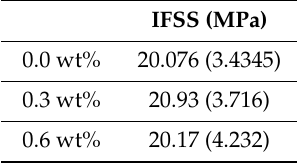
Table 1. The interfacial shear strength (IFSS) between fiber and matrix.